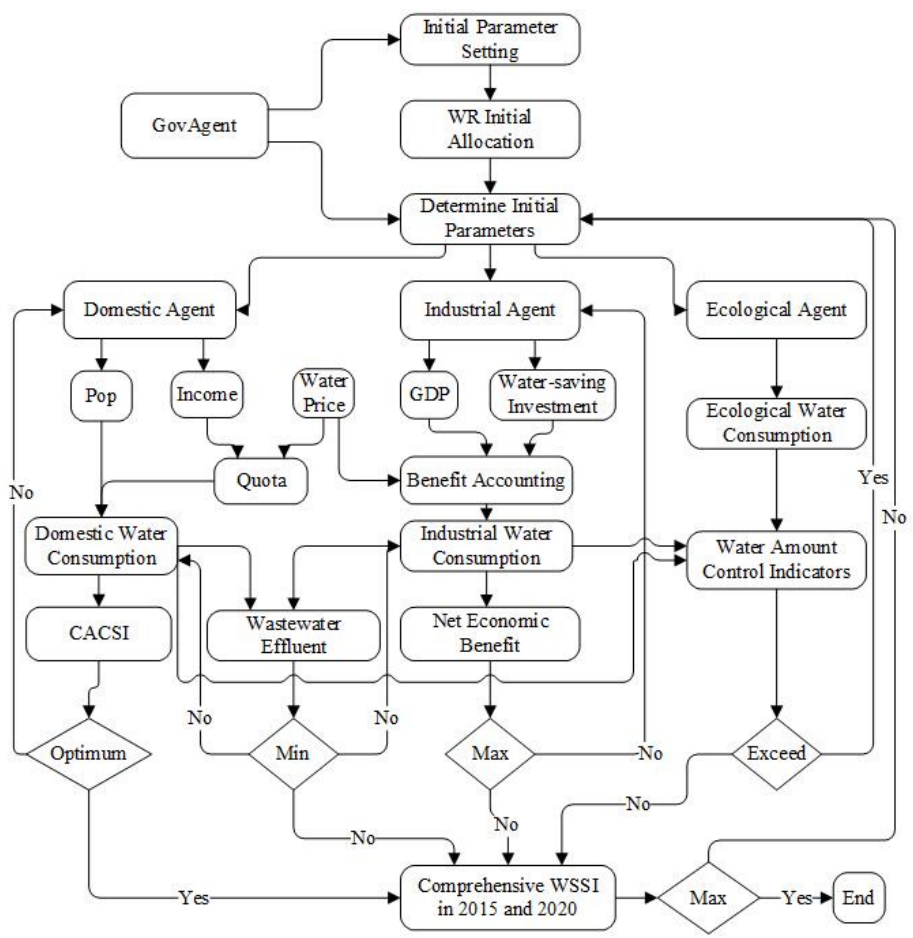
Figure 5. Process for calculating the optimal allocation model for water resources.